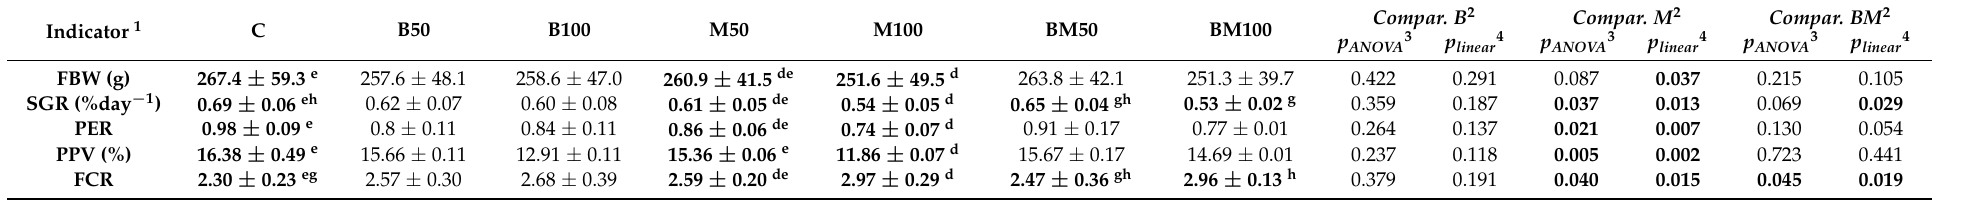
Table 5. Production performance (n = 60/diet group) and protein utilization efficiency (n = 9/diet group) of African catfish (mean ± SD).